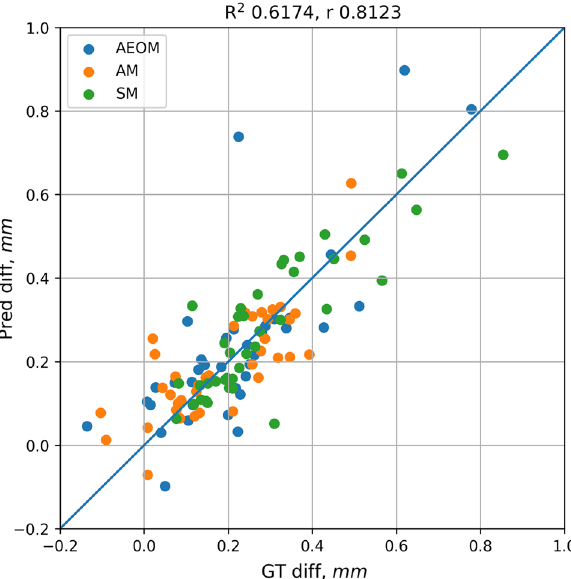
Figure 4. Correlation scatterplot for manual and predicted GA growth rates at month 12 for the different treatment groups. The correlation coefficient across treatment groups was r = 0.81 with an R 2 = 0.62. AEOM every other month, AM monthly treated group, SM sham group, GA geographic atrophy, GT ground